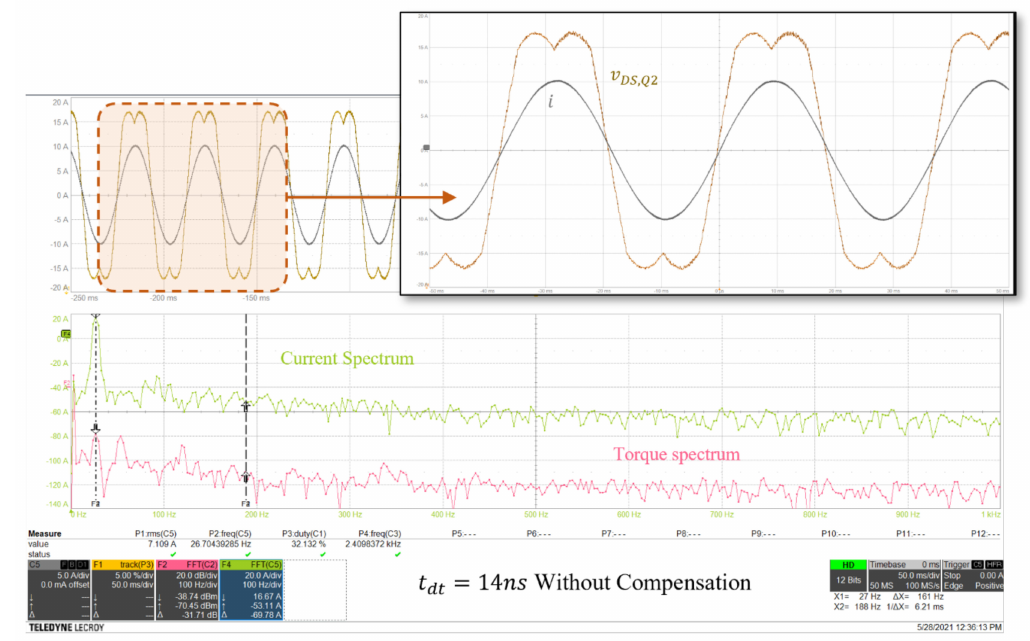
Figure 22. Motor current in the time domain and DFT of phase current and machine mechanical torque 50 ms/div. t dt = 14 ns with no compensation algorithm. C5: motor phase current i = 5 A/div. F1: reconstructed inverter voltage v DS,Q2 =5 V/div. F2: DFT of the mechanical torque 500 mV/Nm. F4: DFT of the inverter phase